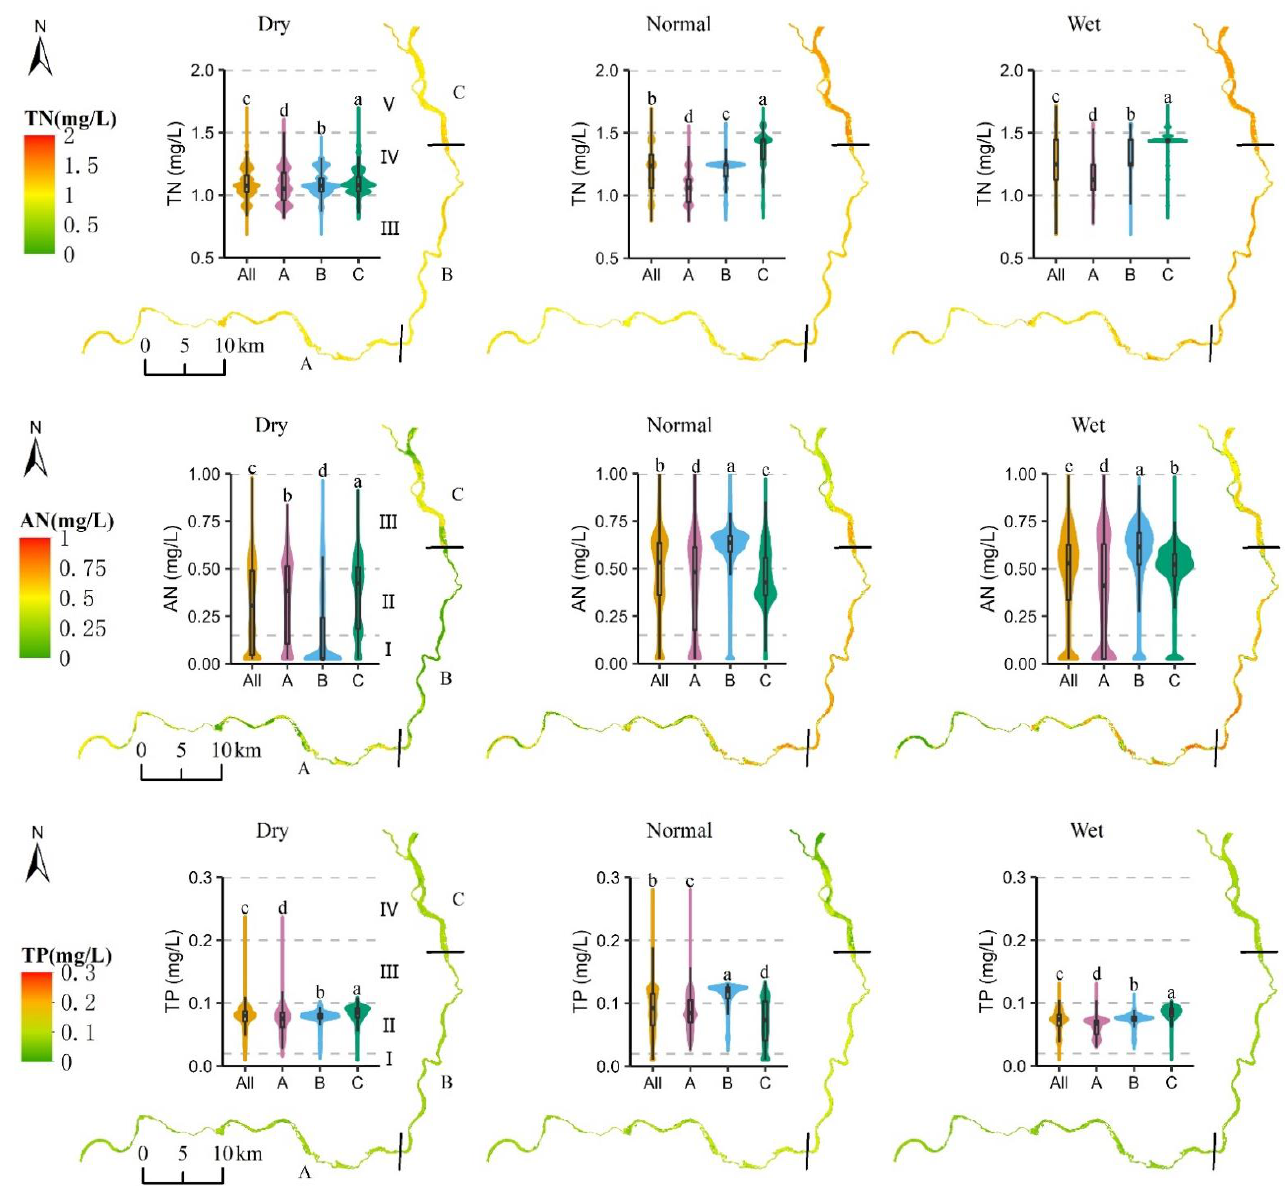
Figure 3. Spatial distributions of mean Landsat 8-monitored TN, AN, and TP concentrations in the whole region of the NRD (All) and three subregions (A, B, and C) in the dry, normal, and wet seasons from 2013 to 2022. Different lowercase letters indicate significant differences at the level of 0.05. Ⅰ , Ⅱ , Ⅲ , Ⅳ , and Ⅴ are the quality standards for surface water from low to high.